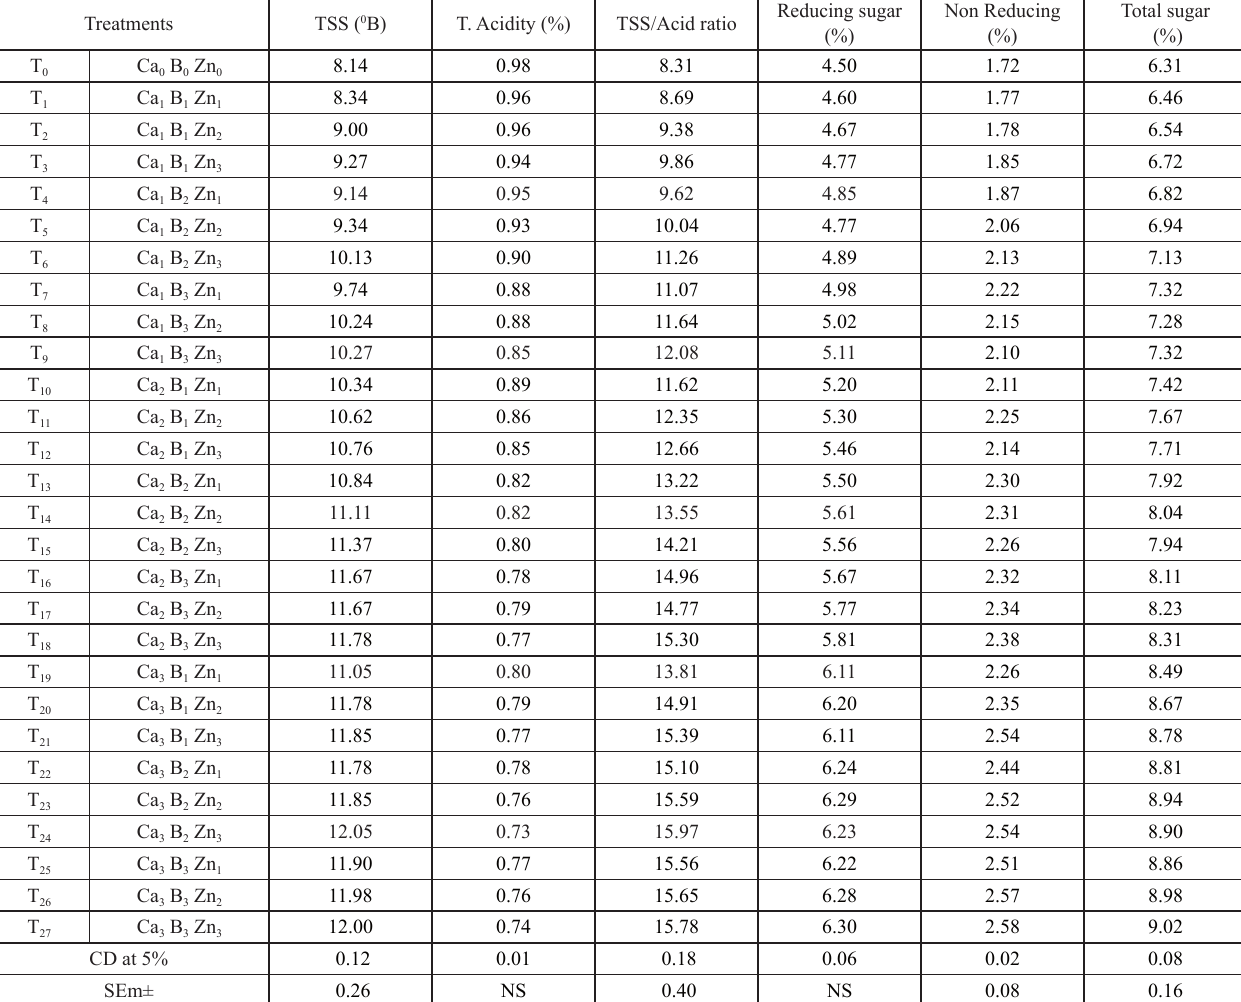
Table 3 Effect of pre-harvest spray of calcium nitrate, boric acid and zinc sulphate on quality characteristics of Nagpur mandarin Treatments